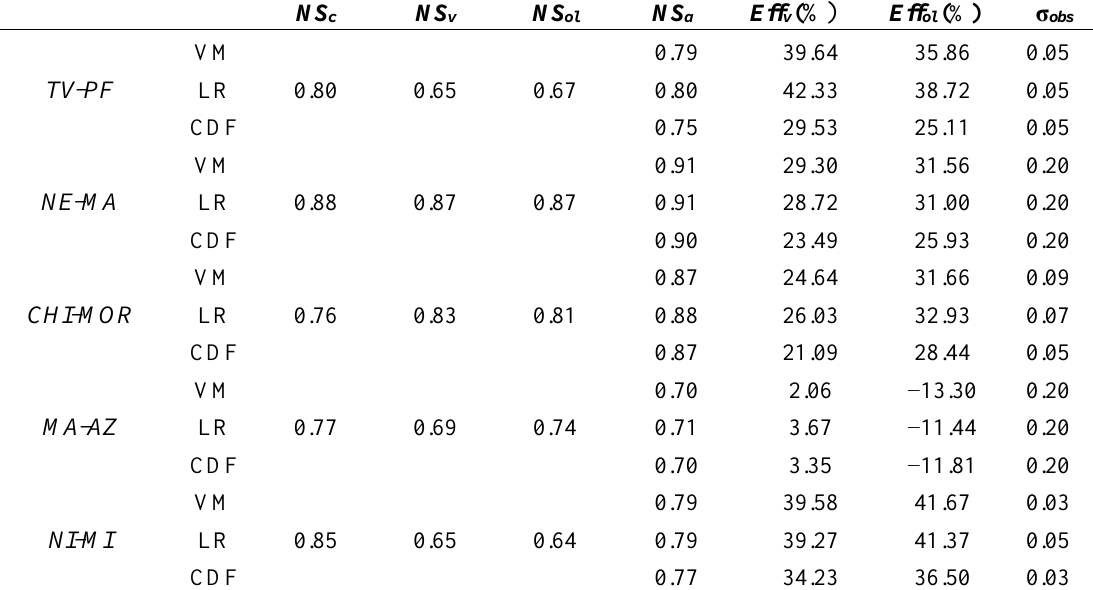
Table 2. Results of the calibration-validation procedures and of the data assimilation experiment for the five selected catchments. NS c is the Nash Sutcliffe efficiency index obtained in calibration from 2000–2009, NS v refers to the same index in validation during 2010–2013, while NS ol is the Nash Sutcliffe calculated in the same validation period on the ensemble mean. On the right part of the table, σ obs refers to the observation error for which the data assimilation provides the best performance in terms of Nash-Sutcliffe ( NS a ). Eff v and Eff ol refer to the results in terms of efficiency in the validation and in the ensemble mean, respectively. Gray cells in the table denote a deterioration with respect to the open loop simulations.